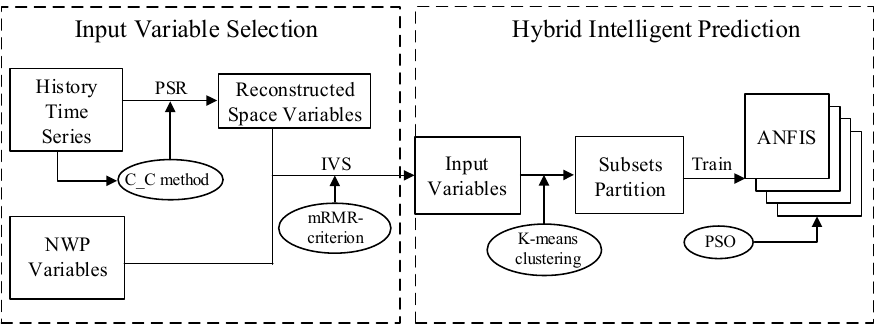
Figure 1. The framework of the proposed hybrid algorithmic solution.